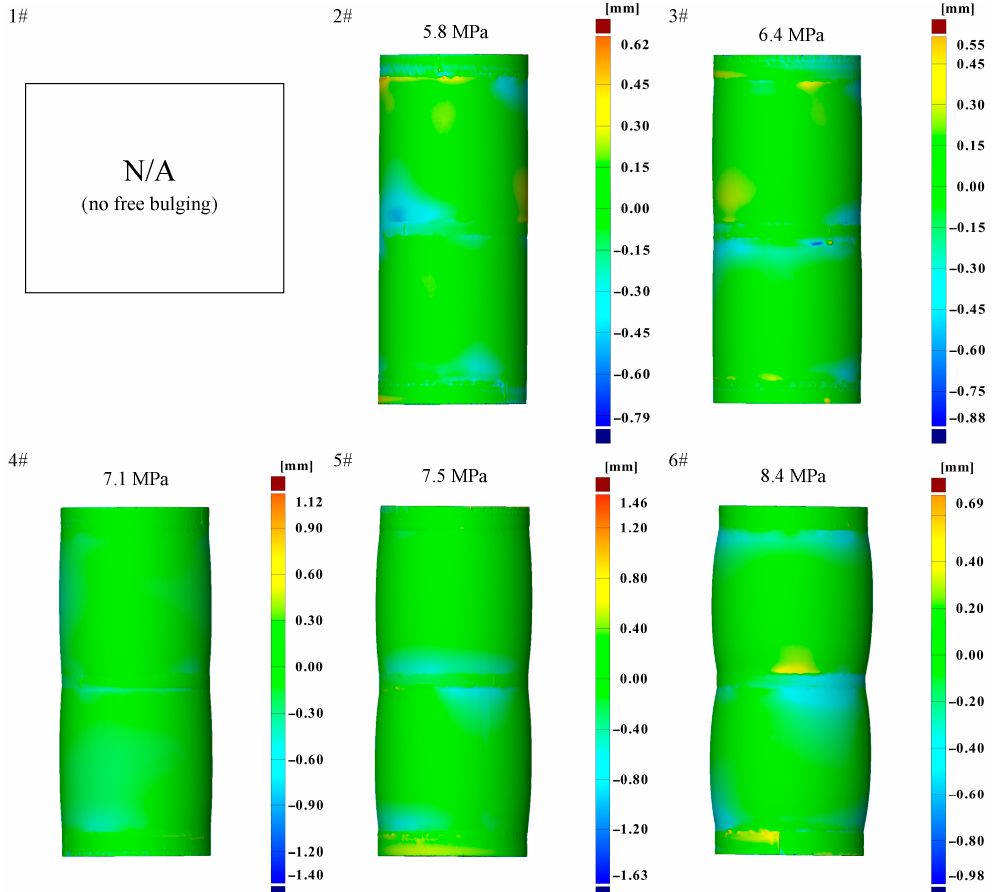
Figure 5. Shape deviations from the perfect geometry for bi-segment bulged hulls.